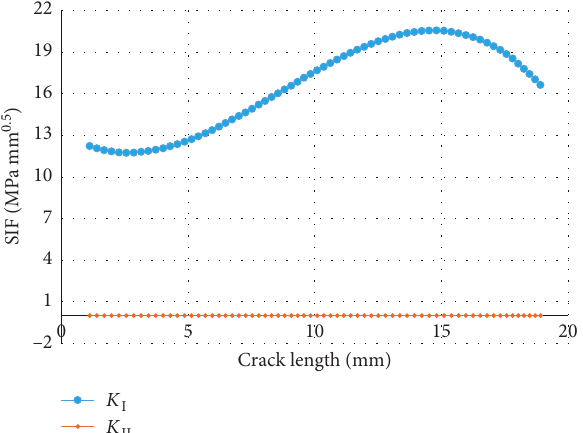
Figure 16: Relationship between SIFs and crack length for crack 2.